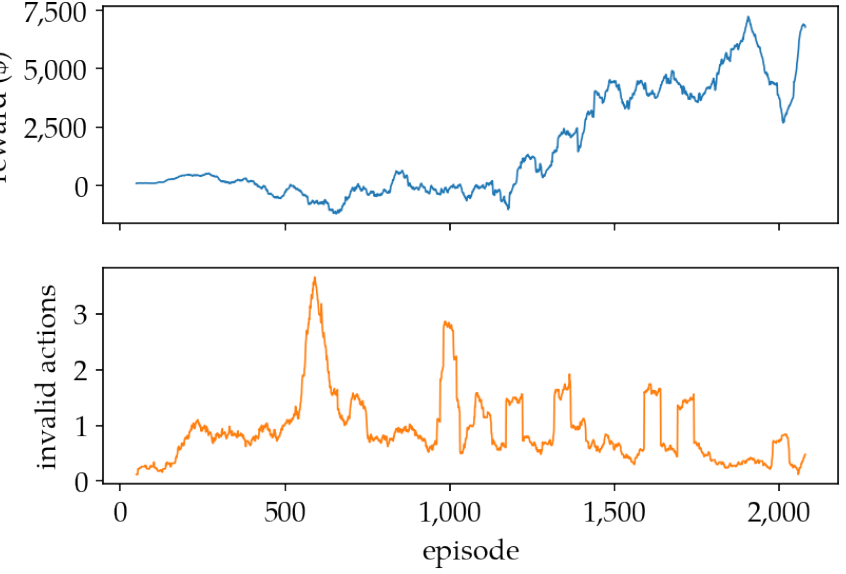
Figure 18. Training curves of the proposed model, averaged over a moving window of 50 episodes (three-day episode